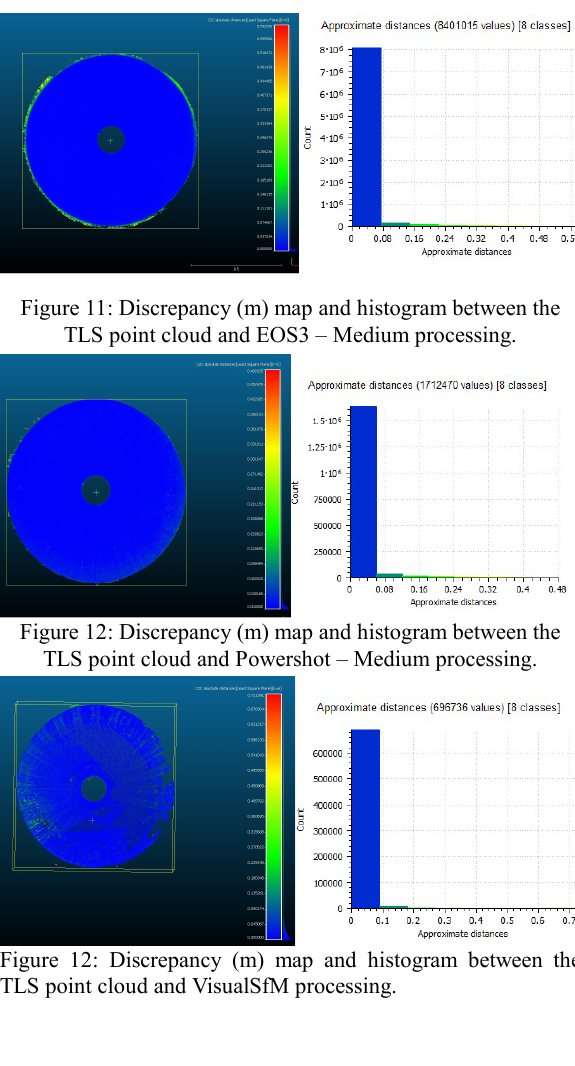
Figure 10: Discrepancy (m) map and histogram between the TLS point cloud and Powershot – UltraHigh processing.